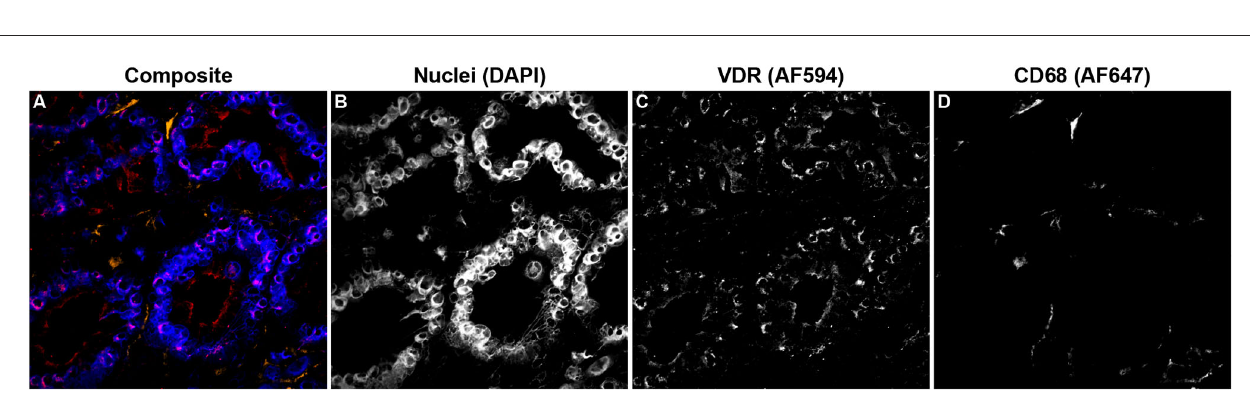
FIGURE10 Confocal microscopy image of frozen mid-ileum tissue section from a cow with clinical stage paratuberculosis. The composite image overlaying each laser channel is presented in (A) . Nuclei (blue) were counterstained using DAPI which was excited on the 405nm laser (B) . VDR (red) expression detected through excitation of an AF594 secondary antibody on the 561nm laser (C) and shows purple where colocalized with nuclei. CD68 (orange) was labeled with an AF647 secondary antibody and excited on the 641nm laser (D)